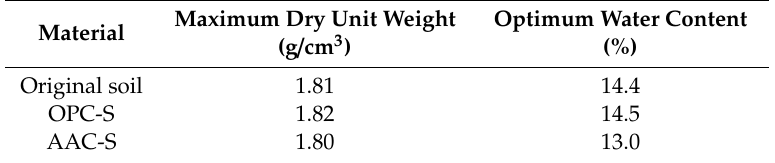
Table 4. Compaction parameters of the chemically stabilised materials, as determined by Proctor tests.